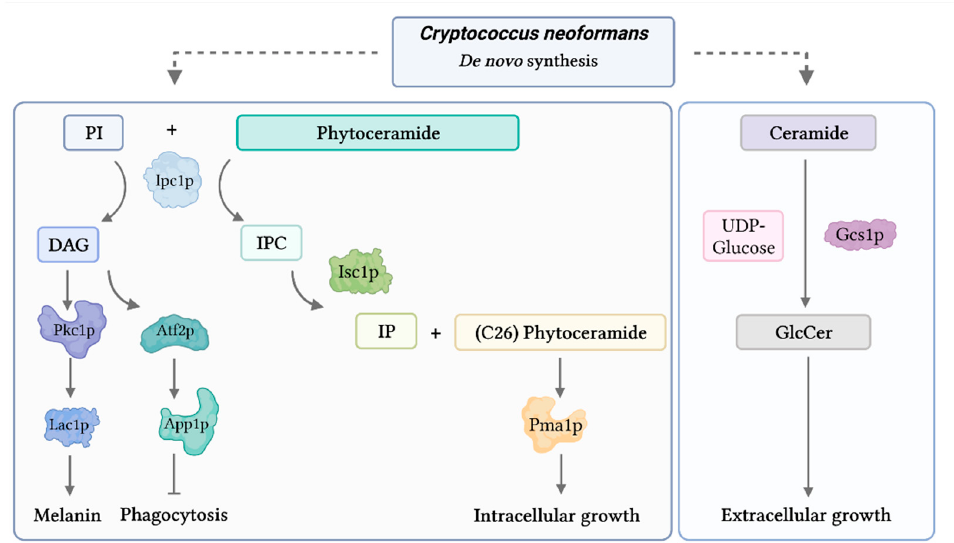
Figure 7. Regulation of lipid pathway in C. neoformans . PI = phosphatidylinositol; Ipc1p = inositol phosphoryl ceramide synthase; IPC = inositol phosphoryl ceramide; DAG = diacylglycerol; Pkc1p = protein kinase C1; Lac1p = laccase; Atf2p = activating transcription factor 2; App1p = antiphagocytic protein 1; Isc1p = inositol phosphosphingolipid phospholipase C; IP = inositol phosphate; Pma1p, plasma membrane ATPase 1; Gcs1p = glucosylceramide synthase; UDP = uridine diphosphate; GlcCer =